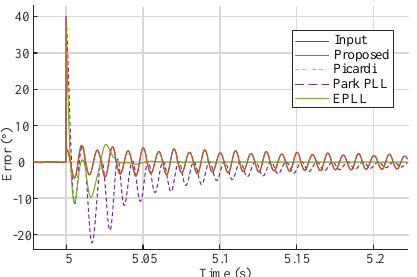
Figure 15. Comparison of phase angle detection errors for a 40° phase jump for a 1 pu and 50 Hz input.